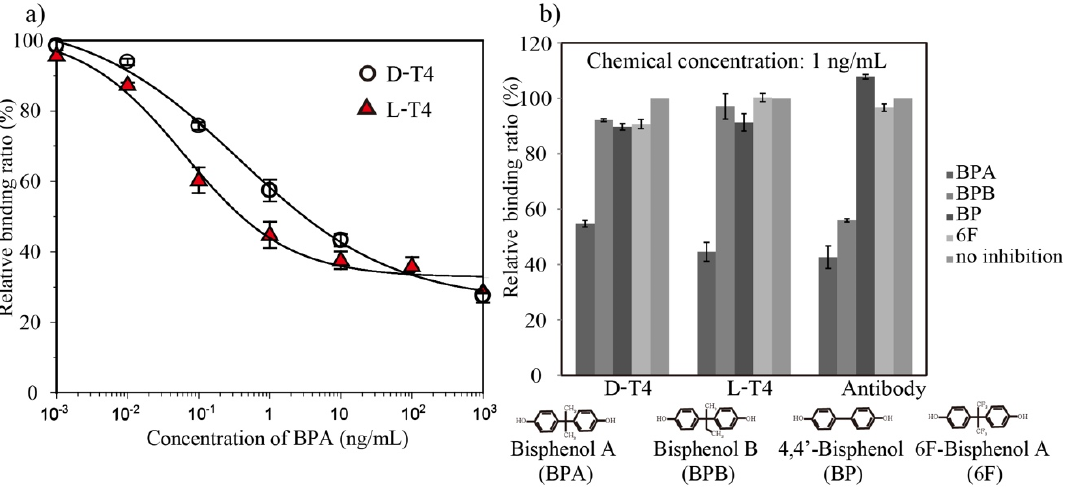
Figure 5. ( a ) A direct competitive ELAA between the BPA-HRP conjugate and free BPA. The BPA aptamers (D-T4 and L-T4) were immobilized on the sensor surface, and subsequent enzyme label detection was performed by BLI. Competition curves were obtained with 200 nM aptamers and a 1/100 dilution of an anti-BPA antibody. The error bars are standard deviations of the mean with n = 3. ( b ) The specificities of the aptamer and antibody for BPA and other analogs. The binding responses for other analogs were measured at the same concentration of 1 ng/mL as BPA.